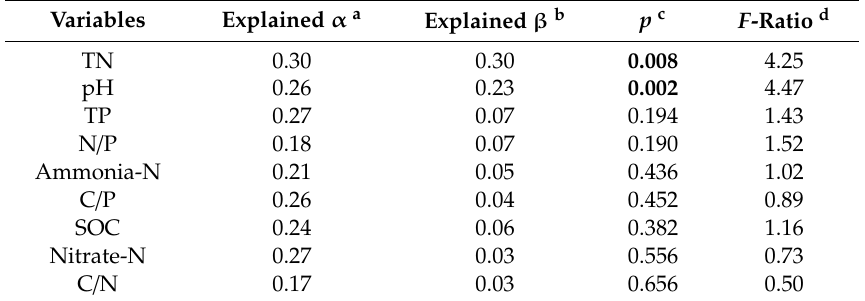
Table 3. Marginal and conditional effects of forward selection through redundancy analysis (RDA). Variables